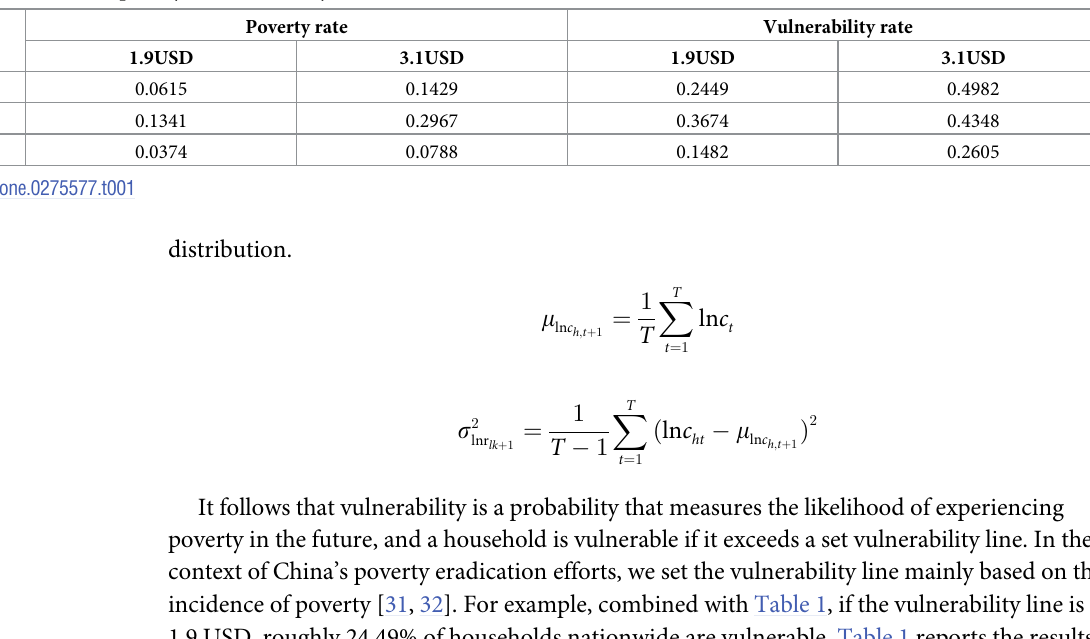
Table 1. Descriptive statistics of household poverty and